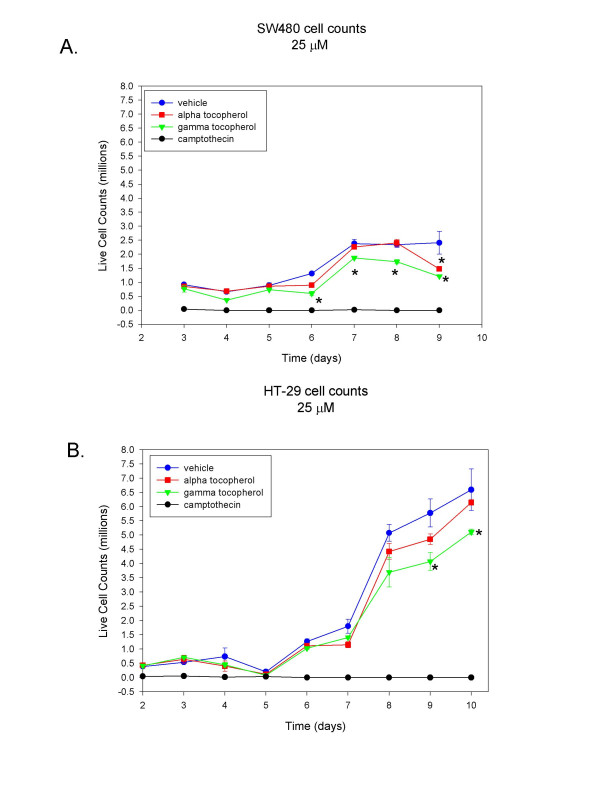
Live Cell Counts following a 25 μM α- and γ-tocopherol treatment at varying times up to ten days in SW480 cells (A) and HT-29 cells (B). (Data are representative of two independent trials performed in triplicate. *p < 0.05 vs. vehicle at corresponding concentration).